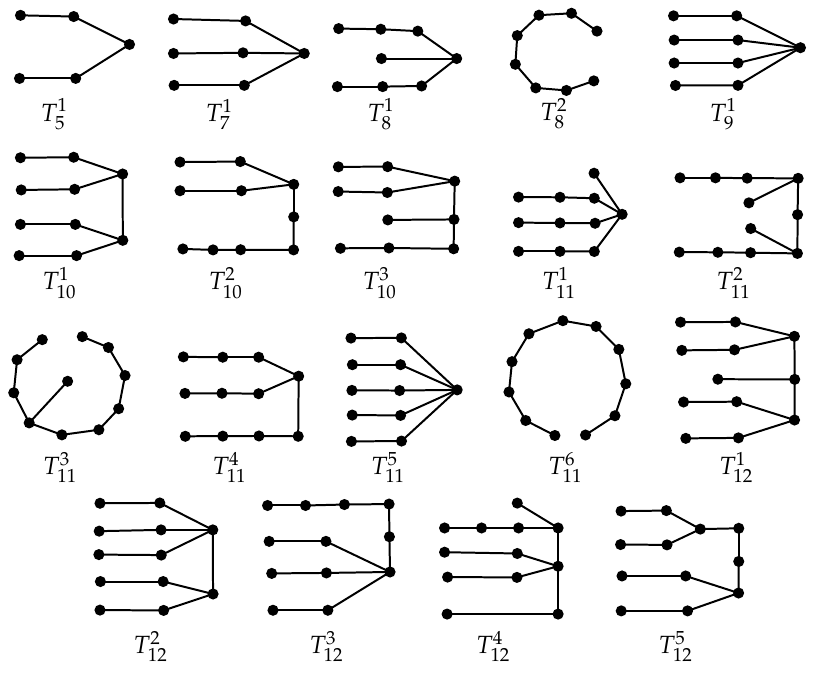
Figure A1. Independent domination stable trees with orders from 5 to 12.